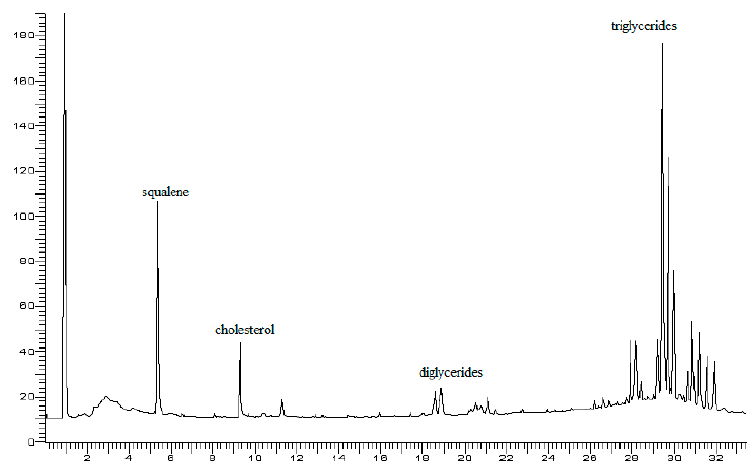
Figure 3. Gas chromatogram of fat extracted from egg pasta with addition of squalene as an internal standard (IS). Carrier flow: 1.5 mL/min.